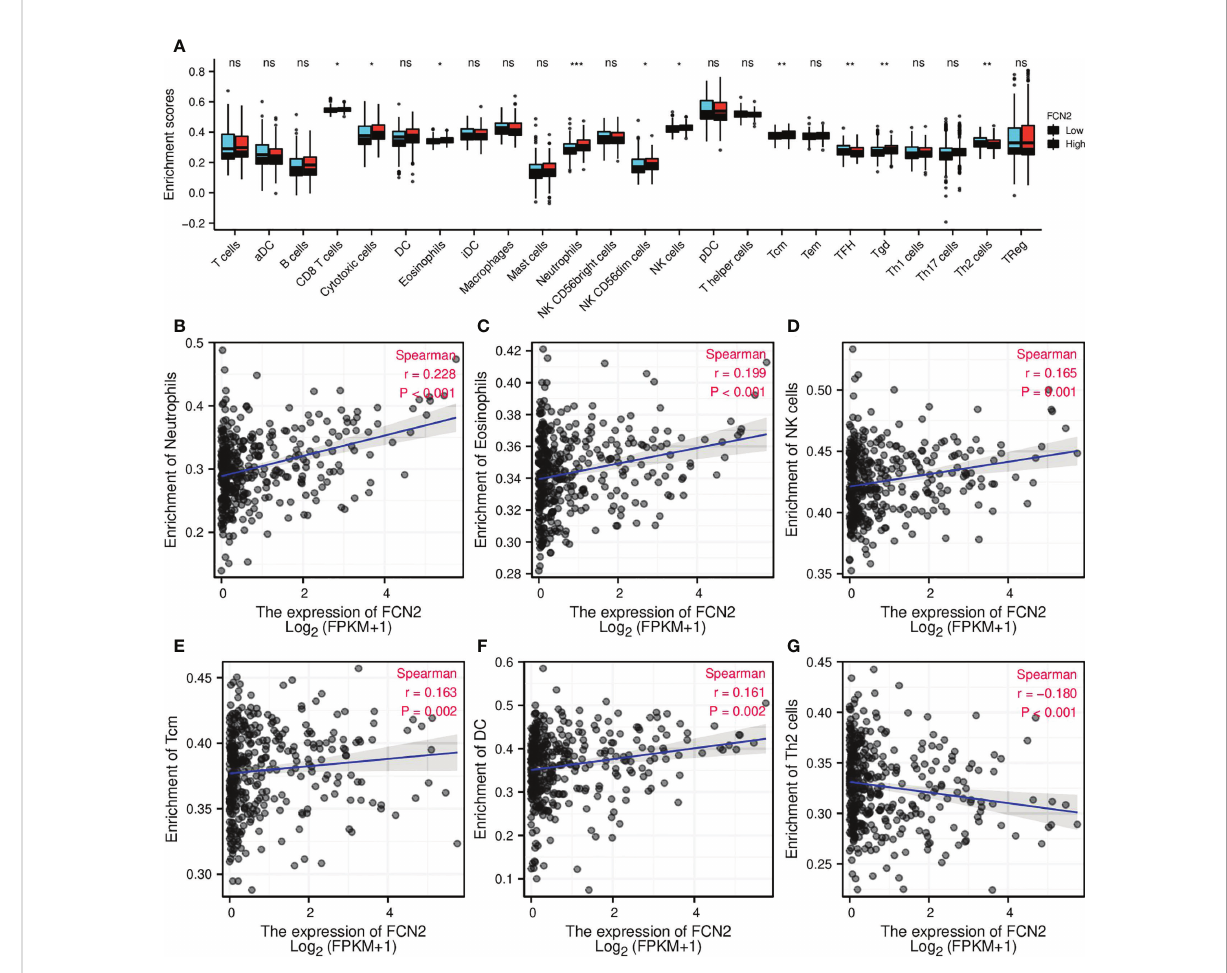
FIGURE 9 Correlation of FCN2 expression with immune characteristics. (A) Differential distribution of the immune cells in patients with high and low FCN2 expressions. (B – G) Correlation between the expression level of FCN2 and immune in fi ltration in hepatocellular